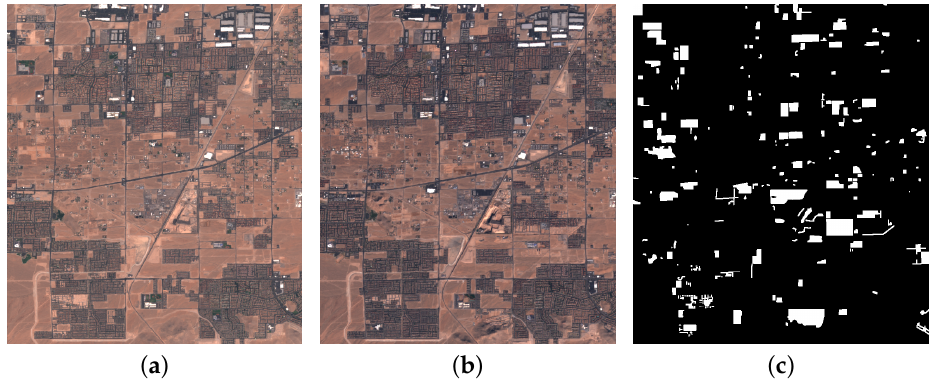
Figure 6. Lasvegas of OSCD. ( a ) Pre-change. ( b ) Post-change. ( c ) ground truth map.